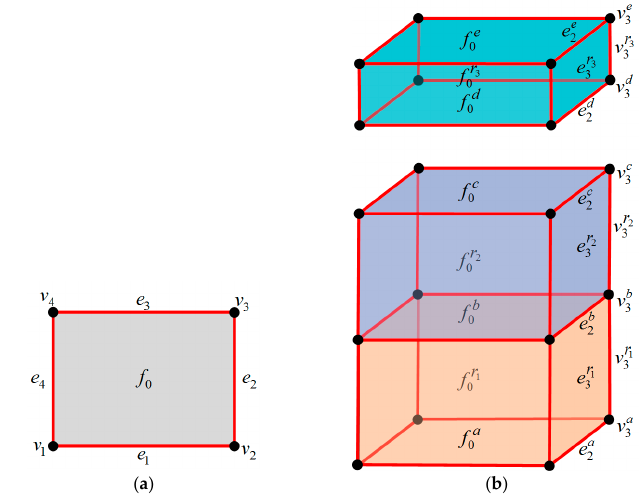
Figure 11. ( a ) Footprint face and its corresponding footprint edges and points; and ( b ) primitives (3D points, edges and faces) that were generated by extruding these footprints.